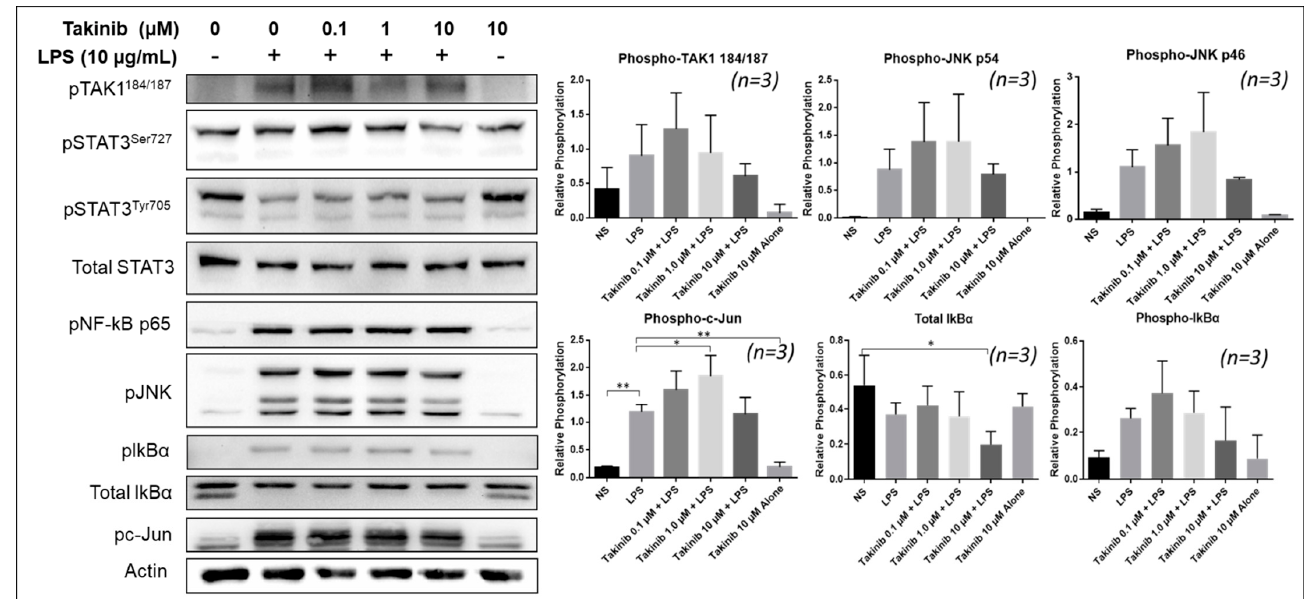
Figure 4. Takinib phosphorylates TAK1 and fails to inhibit the MAPK/NF-kB pathways in THP-1 macrophages. THP-1 monocytes were treated with 100 ng/mL PMA for 3 h, left to rest in fresh RPMI with 10% FBS overnight, followed by 2 h treatment with takinib and an additional 30 min LPS (10 µg/mL) stimulation. NF-kB p65, IkB α , JNK, and c-Jun phosphorylation were all uninhibited, while TAK1 phosphorylation increased under LPS and takinib treatment. * = p < 0.05, ** = p < 0.001.